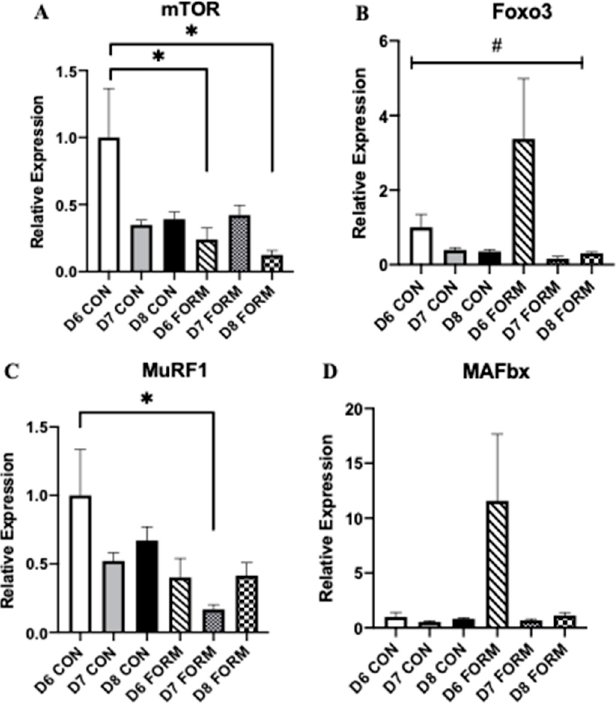
Figure 2. For each figure (n = 5), the symbol (*) is used to represent a significant difference between conditions and the symbol (#) is used to represent an overall significant effect for the ANOVA, with no significant differences between conditions. mTOR ( A ): D6 FORM was decreased compared to D6 CON ( p = 0.015); D8 FORM was decreased compared to D6 CON ( p = 0.004). Foxo3 ( B ): There was an overall significant effect observed ( p = 0.006; F = 4.397). MuRF1 ( C ): D7 FORM was decreased compared to D6 CON ( p = 0.029). MAFbx ( D ): There were no changes in expression between conditions.